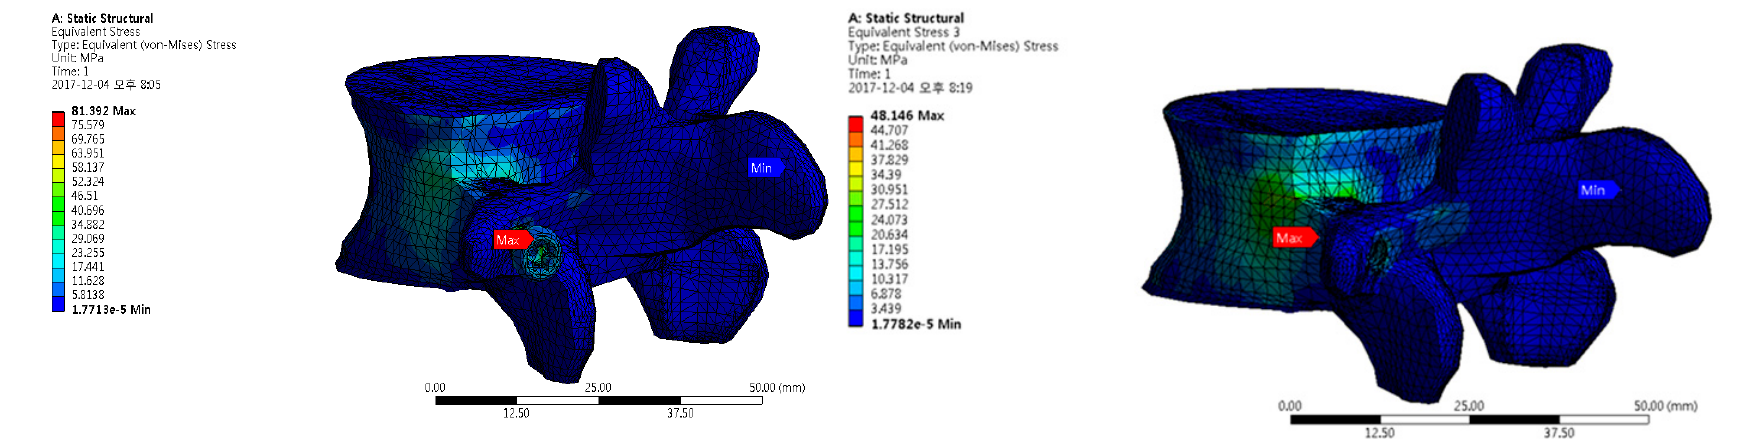
Figure 9. FEA results for the double-threaded pedicle screw: Top is the pedicle screw, left is L4 and the pedicle screw, and right is Fig. 9